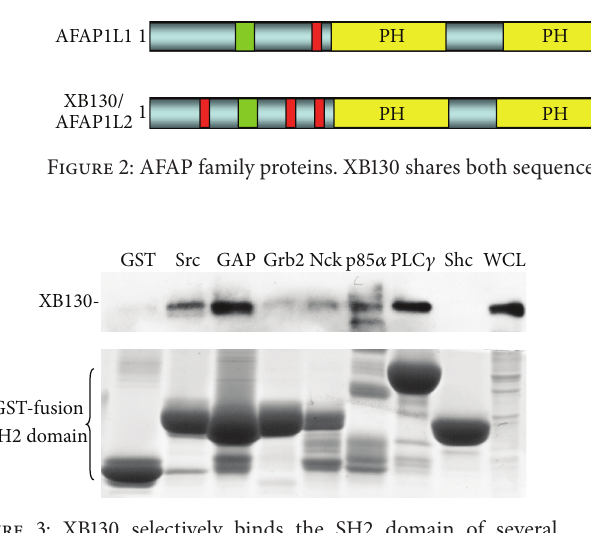
Figure 3: XB130 selectively binds the SH2 domain of several proteins. GST fusion protein pull-down assay shows that XB130 binds to the SH2 domain of Src, GAP, p85 𝛼 subunit of PI3K, and PLC 𝛾